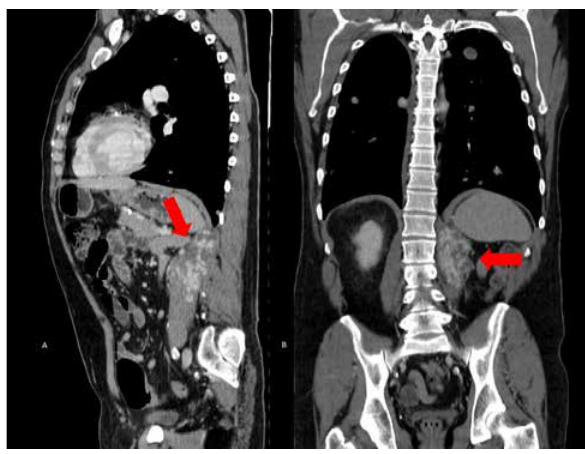
Figure 4: Axial (a) and coronal (b) reconstruction on ct scan showing a local recurrence of tumoral tissue (red arrow) in the left kidney lodge, alongside the parieto-colic ligament.